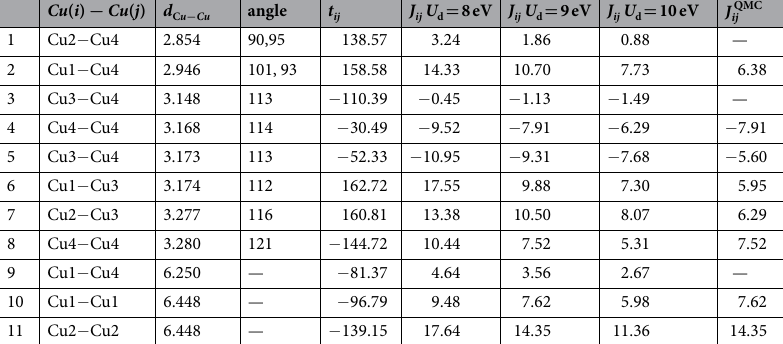
Table 1. Magnetic interactions in KCu 5 O 2 (SeO 3 ) 2 Cl 3 : crystallographic positions of the interacting copper atoms, the Cu–Cu distances d (in Å), the relevant Cu–O–Cu bridging angles (in deg), hopping parameters t ij (in meV), and total exchange couplings J ij (in K) obtained from DFT + U . The last column represents optimized values used in QMC simulations. The negative signs of the exchange integrals stand for ferromagnetic interactions. See Fig. 6 for details of the interaction network.